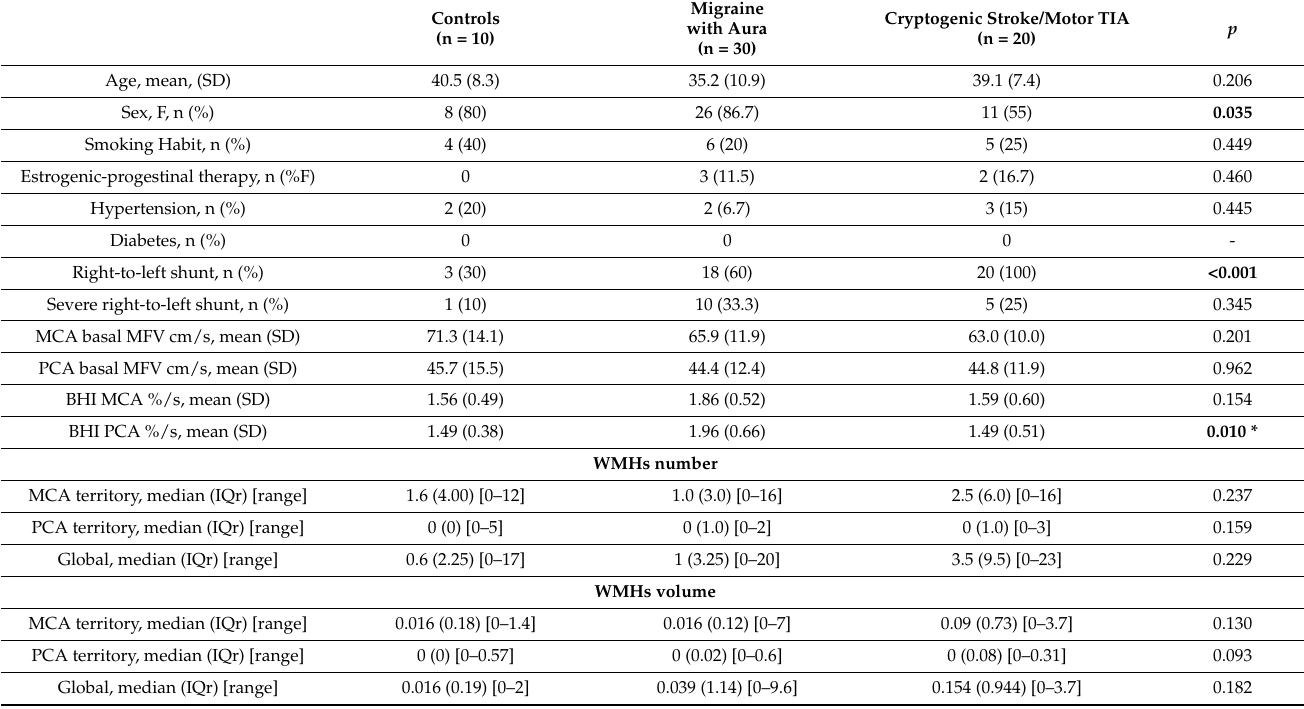
Table 2. Demographic and clinical characteristics, vascular risk factors, hemodynamic parameters and WMHs load for each group of